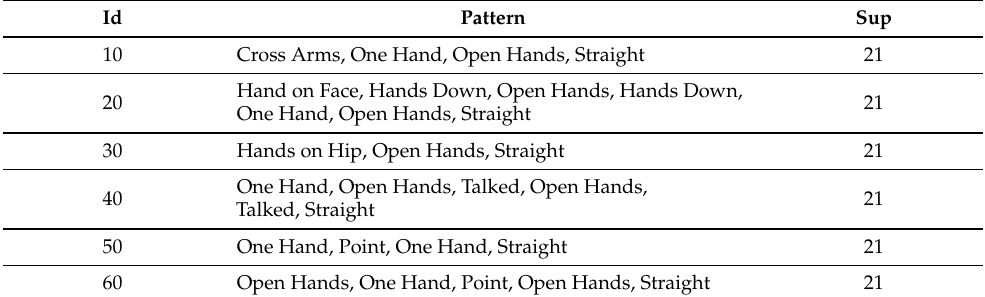
Table 6. Selected sequences from presentation 2 of year 1.